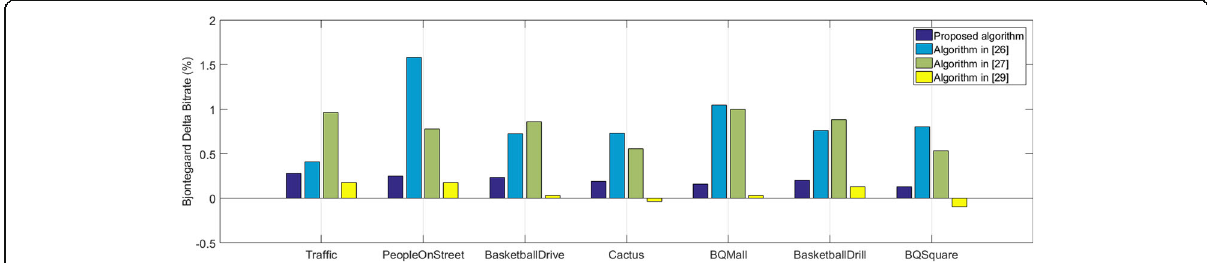
Fig. 13 Bitrate increase comparison of the proposed algorithm and the algorithms in [26, 27, 29] in RA